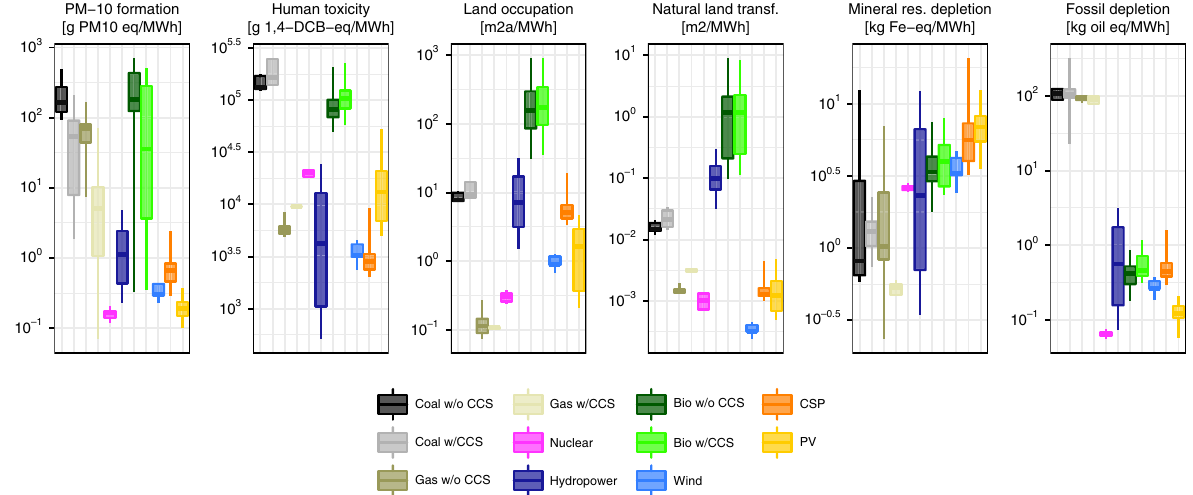
Fig. 3 Selected technology-speci fi c environmental impacts. Per unit life-cycle impacts of electricity technologies for the FullTech scenario and the year 2050 for impact indicators dominating the endpoints human health, ecosystem damages and resource depletion. Boxplots indicate median and interquartile ranges across technology variants and participating integrated assessment models, whiskers 10th − 90th percentile ranges. Ranges do not re fl ect uncertainty in environmental impact characterization. The full set of indicators is displayed in Supplementary Fig.